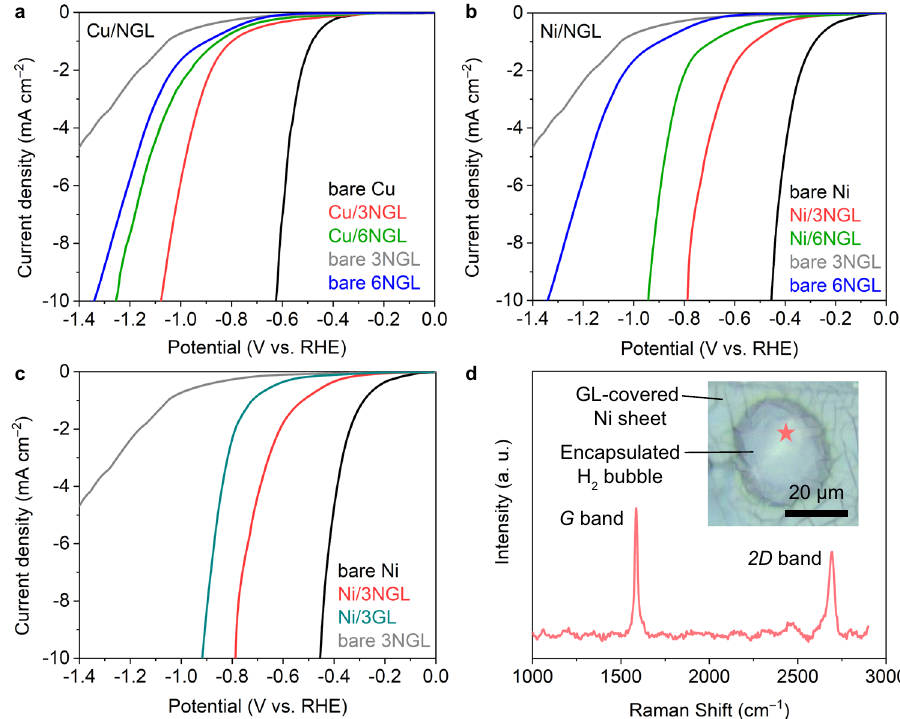
Fig. 2 HER activities of the graphene-covered Cu and Ni sheets. HER polarization curves of the graphene-covered ( a ) Cu and ( b , c ) Ni sheets. d Raman spectra of the 3GL on a H 2 bubble after the HER test. Inset of ( d ): the optical photo shows that a H 2 bubble was generated between the Ni sheet and the graphene layers. The Raman measurement was obtained at the location indicated by the red